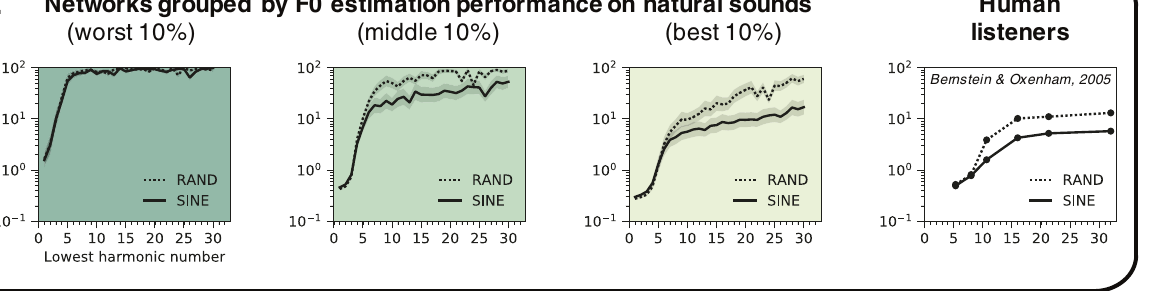
Fig. 3 Network architectures producing better F0 estimation for natural sounds exhibit more human-like pitch behavior. a – e Plot human-model similarity in each experiment for all 400 architectures as a function of the accuracy of the trained architecture on the validation set (a set of stimuli distinct from the training dataset, but generated with the same procedure). The similarity between human and model results was quanti fi ed for each experiment as the correlation coef fi cient between analogous data points (Methods). Pearson correlations between validation set accuracy and human-model similarity for each experiment are noted in the legends. Each graph a – e corresponds to one of the fi ve main psychophysical experiments (Fig. 2a – e): a F0 discrimination as a function of harmonic number and phase, b pitch estimation of alternating-phase stimuli, c pitch estimation of frequency-shifted complexes, d pitch estimation of complexes with individually mistuned harmonics, and e frequency discrimination with pure and transposed tones. f The results of the experiment from a (F0 discrimination thresholds as a function of lowest harmonic number and harmonic phase) measured from the 40 worst, middle, and best architectures ranked by F0 estimation performance on natural sounds (indicated with green patches in a ). Lines plot means across the 40 networks. Error bars indicate 95% con fi dence intervals via bootstrapping across the 40 networks. Human F0 discrimination thresholds from the same experiment are re-plotted for